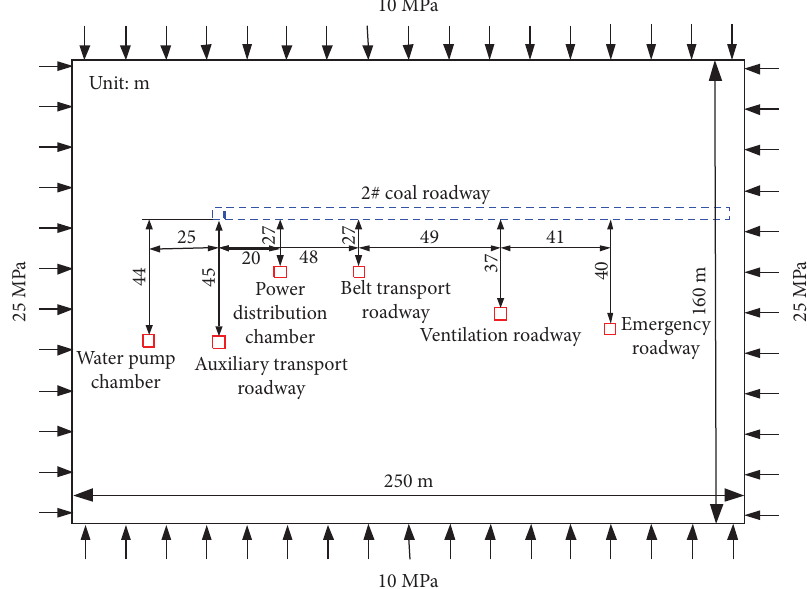
Figure 5: Stress release model of 3# coal chamber